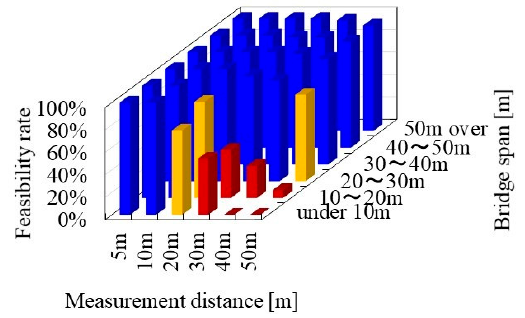
Figure 14. Relationship between the span length and the maximum measured bridge displacement (246 high-speed railway bridges). Table 7. Number of bridges and the span length used in the calculation.